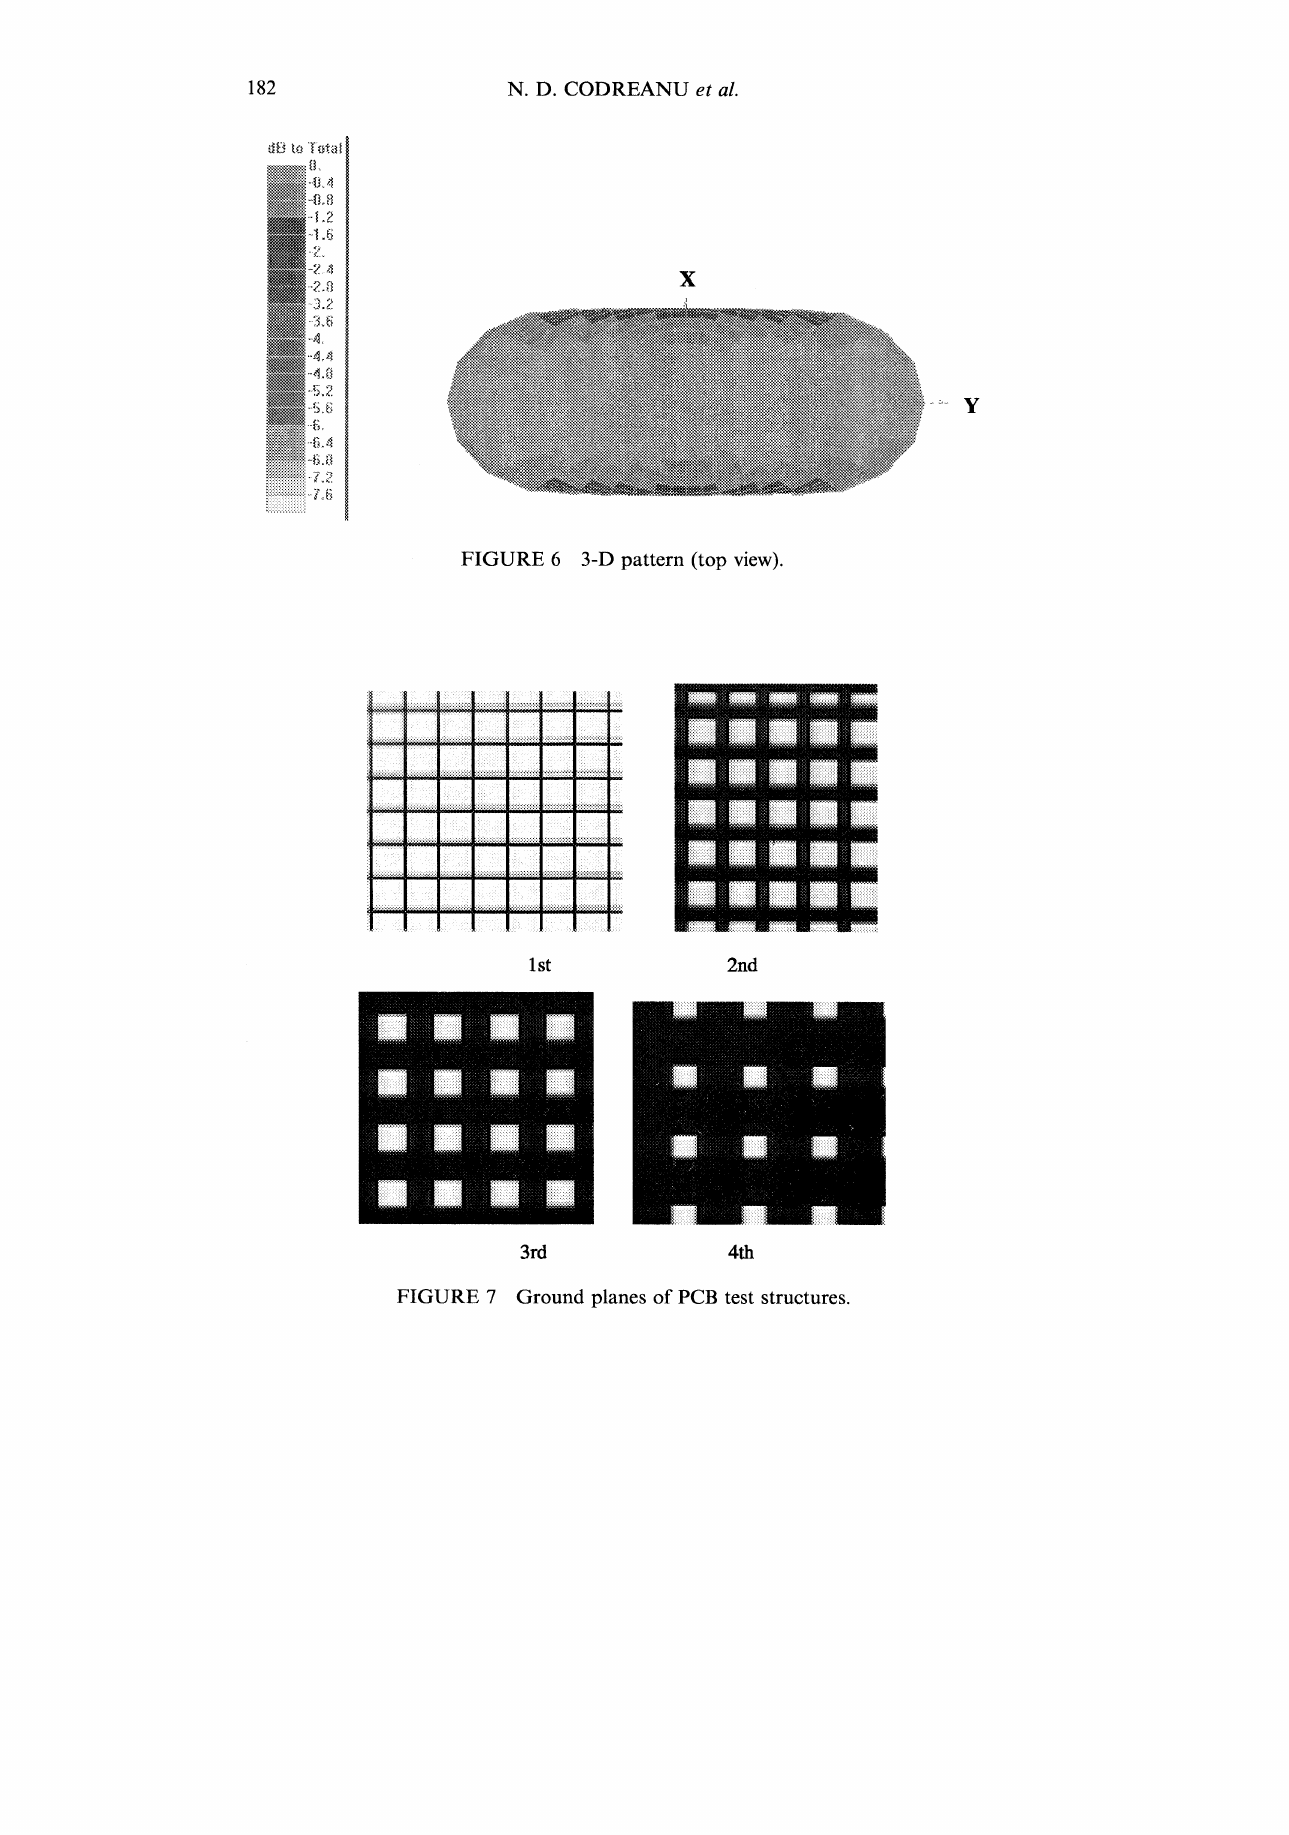
FIGURE 6 3-D pattern (top view).